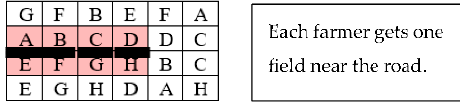
Figure A2. Game board in Xiengdaene Village.